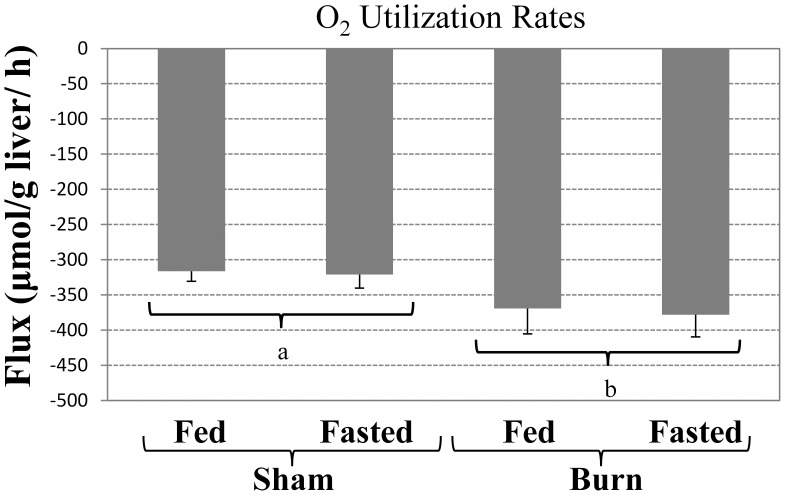
Average oxygen utilization rates in perfused livers.Data shown were obtained from the measured decrease in oxygen tension and hemoglobin saturation between the outlet and inlet of each perfused liver. Bars labeled with different letters are statistically significantly different (ANOVA, P<0.05; N≥3) from each other. Data shown are means±SD.